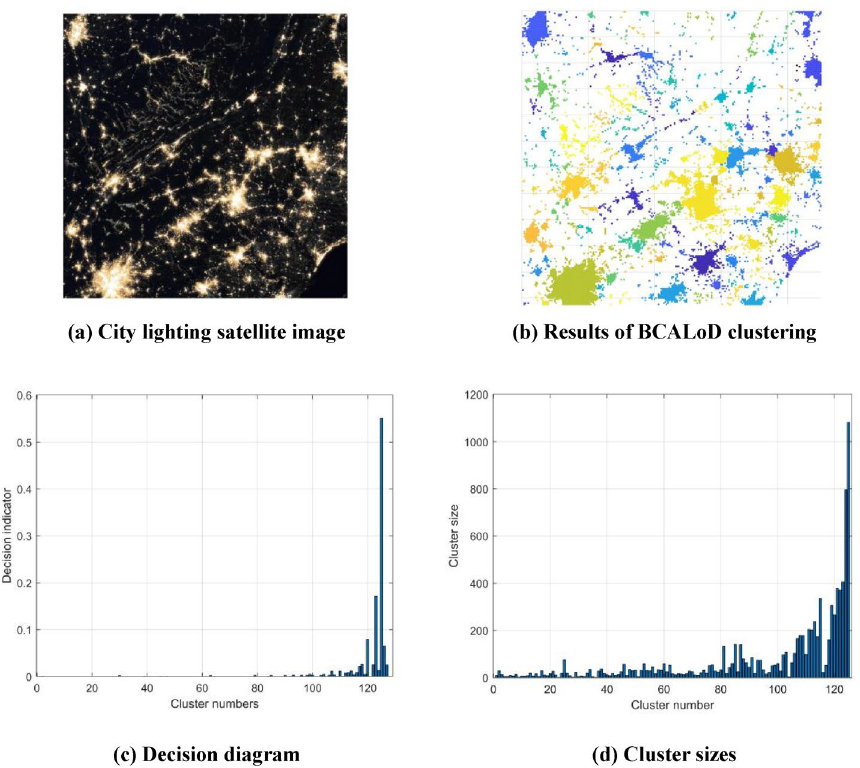
Figure 7. Clustering results of city lighting satellite image. ( a ) A NASA city light satellite image was selected as the dataset. This was also done to verify the BCALoD algorithm’s ability to cluster datasets with multiple cluster centers and small clusters. ( b ) The BCALoD algorithm was used to do cluster analysis on the images, and the clustering results obtained. ( c ) Decision diagram of satellite image BCALoD clustering. The number of